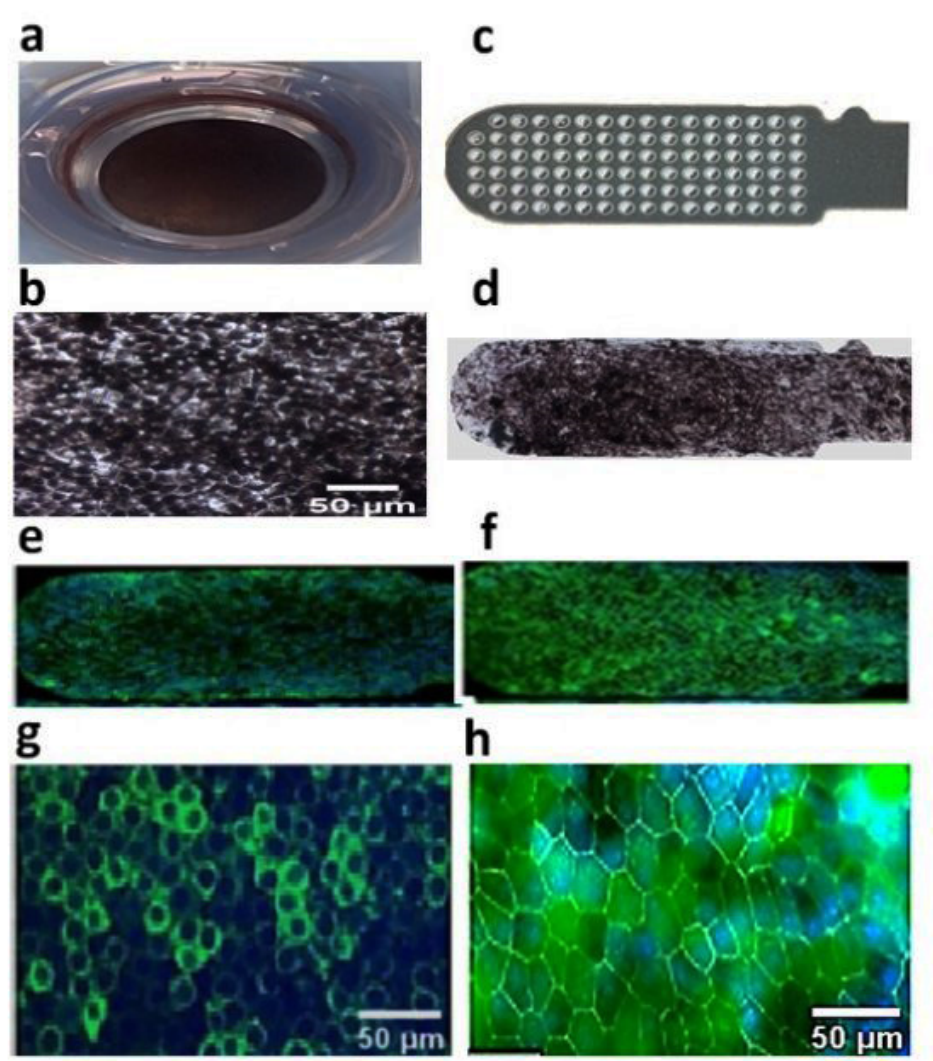
Figure 1. iPSC-RPE grown as polarized monolayer over parylene substrate. ( a ) iPSC-RPE polarized monolayer cultured on 24-well transwell insert, ( b ) enlarged view of iPSC-RPE monolayer, ( c ) ul- trathin parylene membrane without cells, ( d ) iPSC-RPE grown as polarized monolayer on parylene membrane, low magnification (10 × ) image showing the whole implant stained for (e) RPE 65 ( f ) ZO-1 expression, enlarged view of expression of ( g ) RPE 65 and ( h ) ZO-1 on parylene